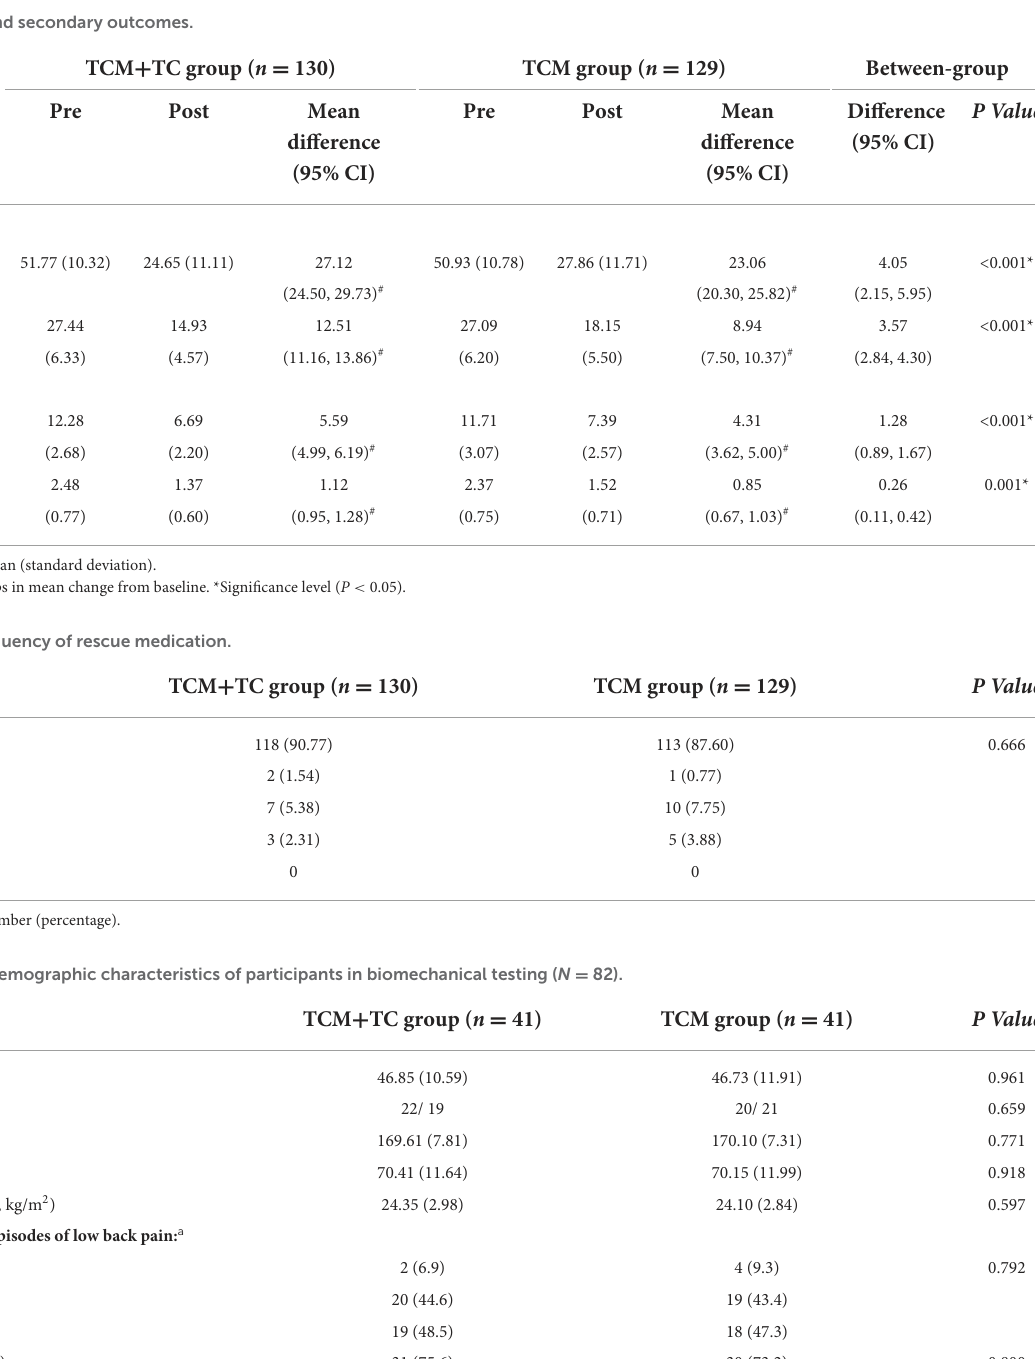
TABLE 3 Primary and secondary outcomes.